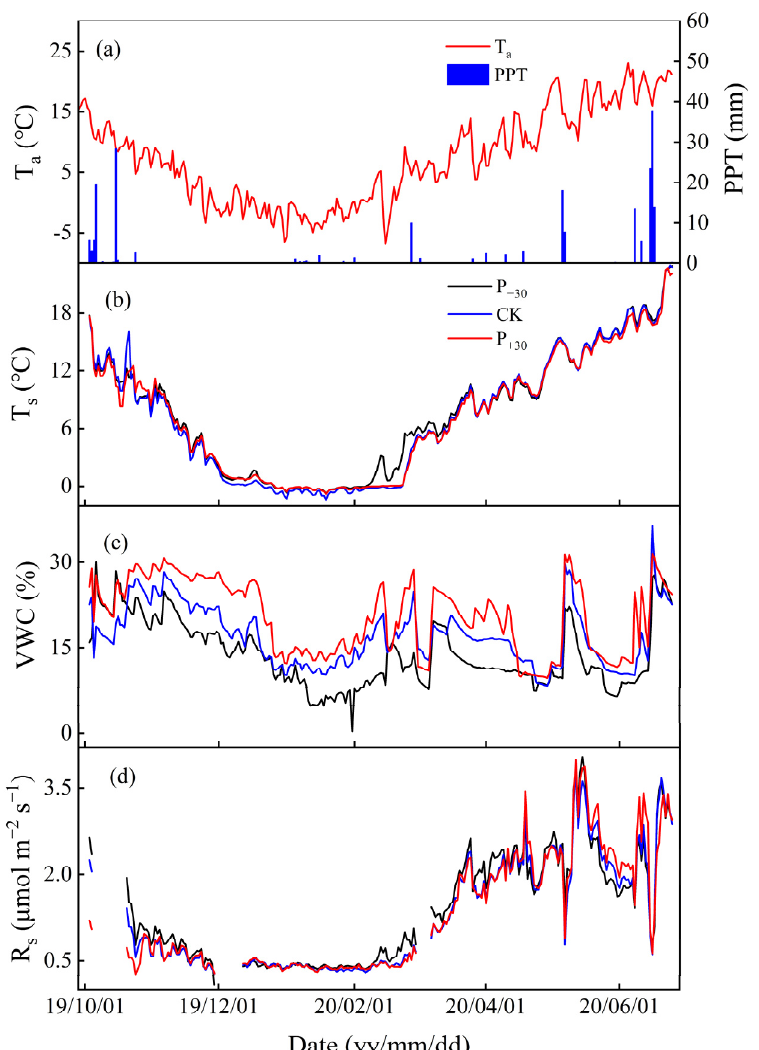
Figure 1. Variations in air temperature, T a , (a); ambient precipitation, PPT (a); soil temperature, T s (b); soil volumetric water content, VWC (c); and soil respiration, R s (d) in the three precipitation treatments (P − 30 = 30% decreased precipitation, CK = natural precipitation, P +30 = 30% increased precipitation) during the winter wheat whole growth period. T s and VWC were measured at 10 cm depth.